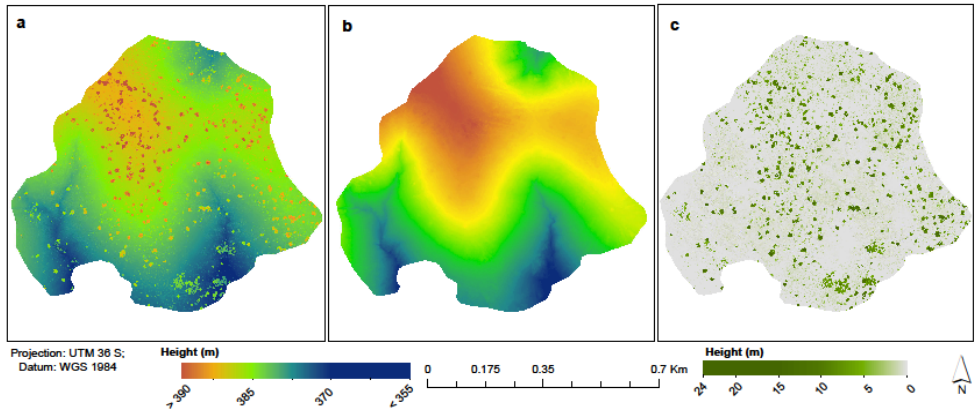
Figure 3. TLS ‐ derived ( a ) digital surface model; ( b ) digital terrain model; and ( c ) canopy height model .